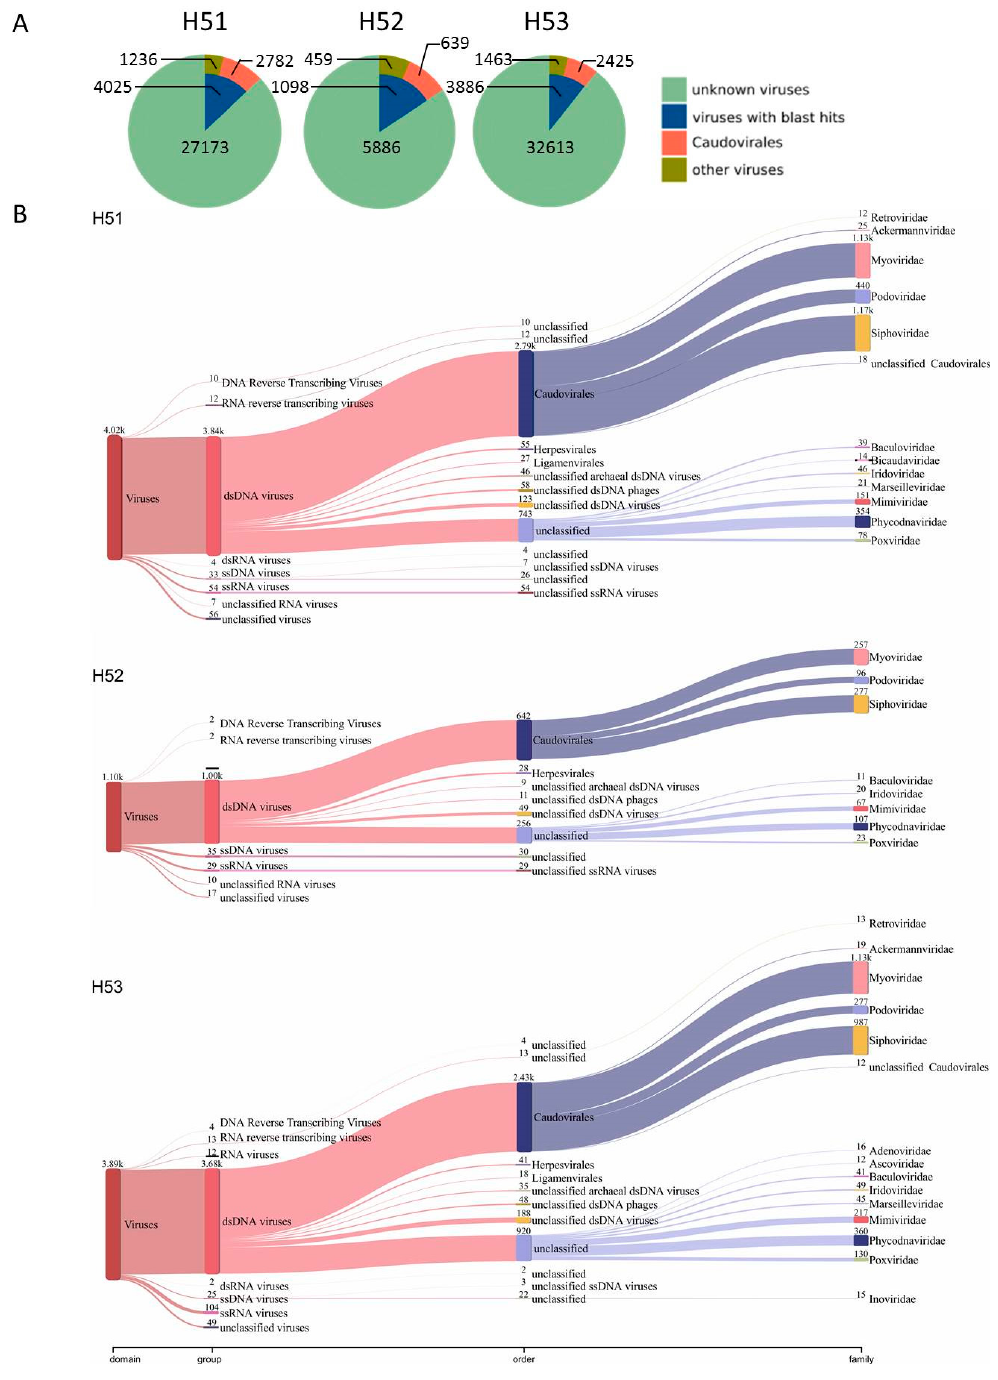
Figure 5. Taxonomic assignment of viral contigs identified from cross-assemblies. ( A ) pie charts present relative and absolute abundance of viral contigs after blastp analysis. ( B ) Taxonomic profile of viral contigs as classified by blastp (viral contigs with blast hits in figure A ). Data were visualized with Pavian [71].